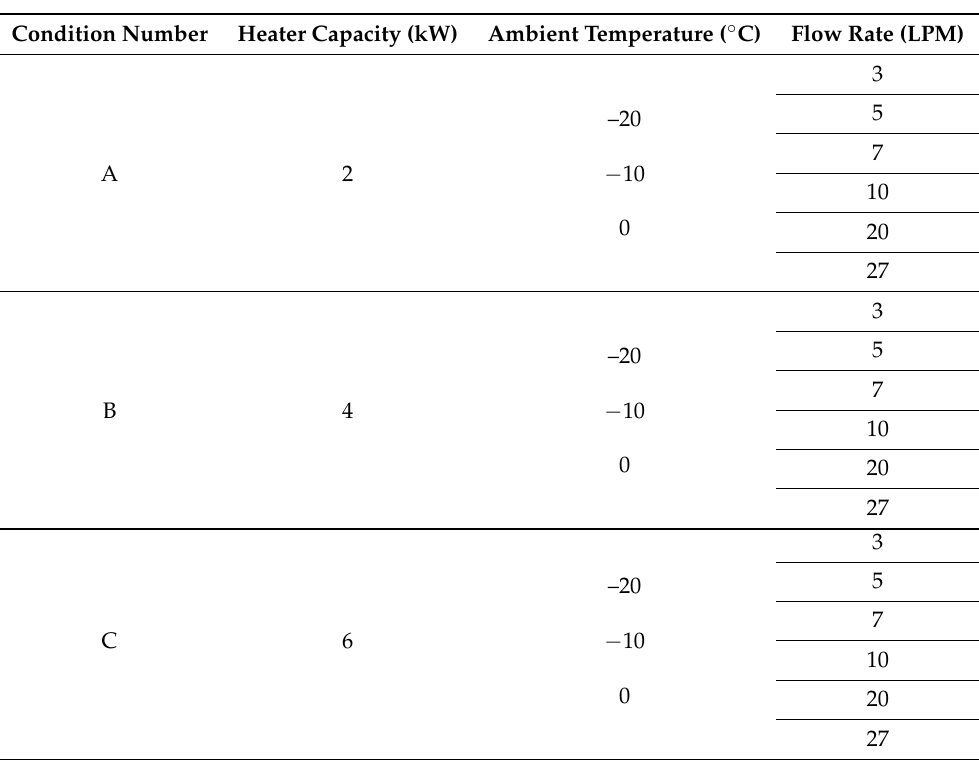
Table 5. Experimental conditions of a battery